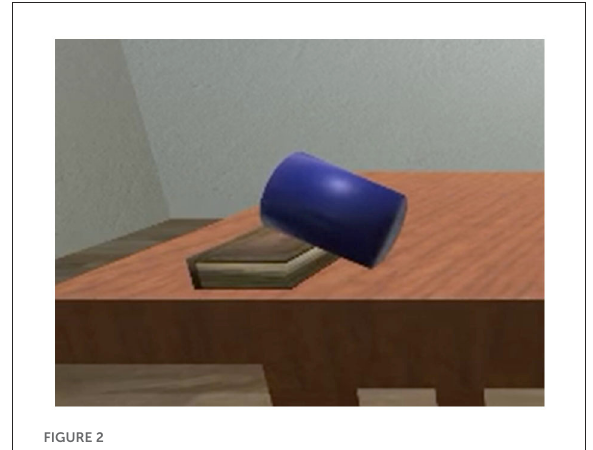
FIGURE2 Visualization of “lean the cup on the